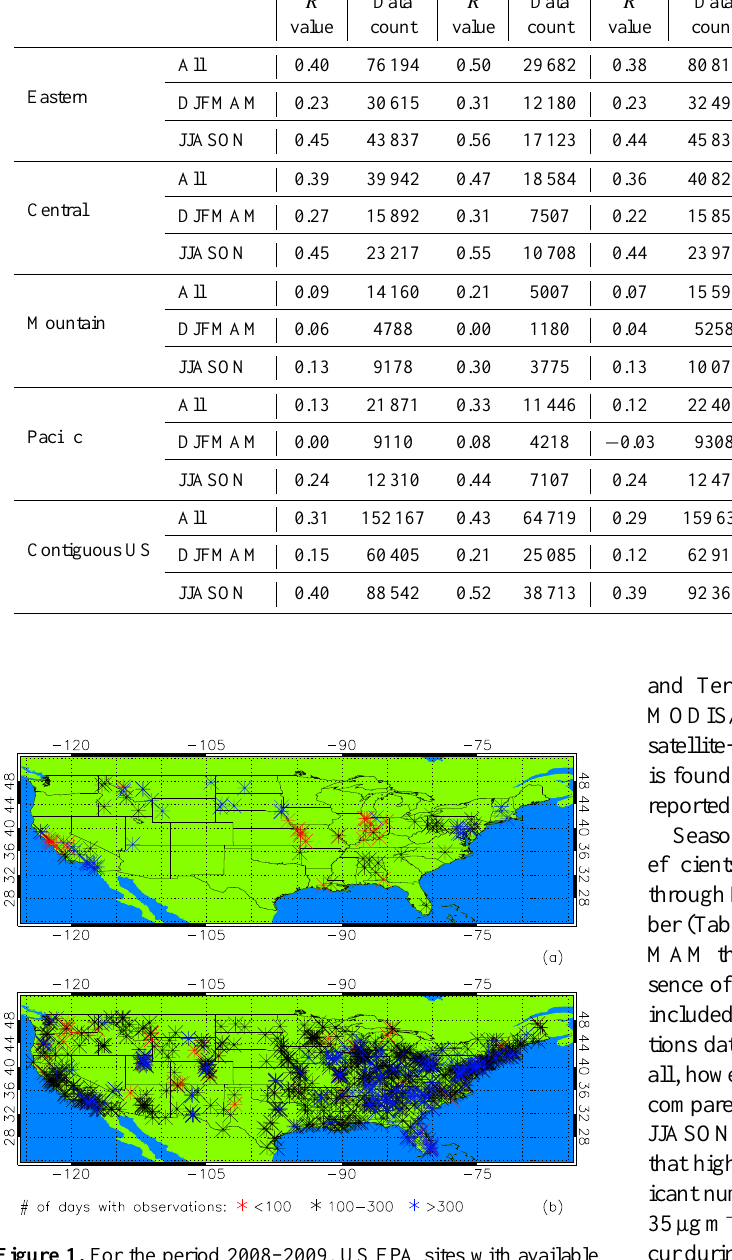
Figure 1. For the period 2008–2009, US EPA sites with available PM 2 . 5 measurements at (a) hourly and (b) daily intervals, respec- tively. The sites are color-coded based on number of days with ob- servations as red (fewer than 100), black (between 100 and 300), or blue (greater than